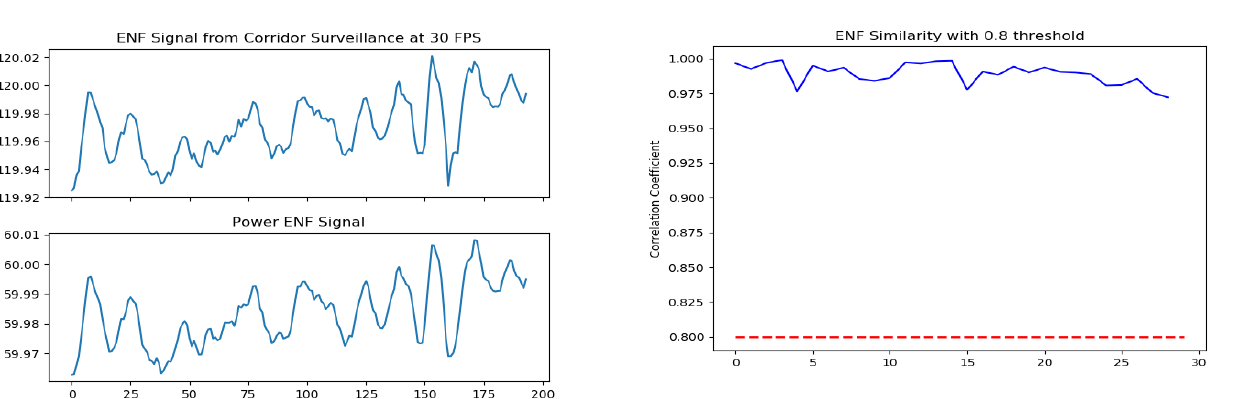
Figure 8. Correlation coefficient for Fig.